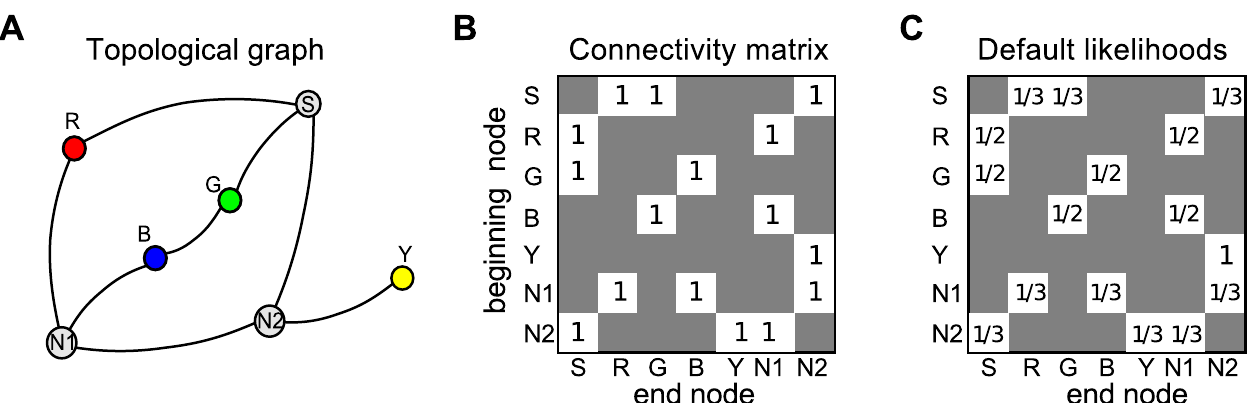
Fig 7. Connectivity and default decision matrix. A) Topological graph for Layout 1. ‘S’ indicates the Start location where participants entered the maze and ‘N1’ and ‘N2’ are nodes in the graph indicating 3-way junctions in the maze. B) Corresponding connectivity matrix. C) Default likelihoods of steps, prior to the learning